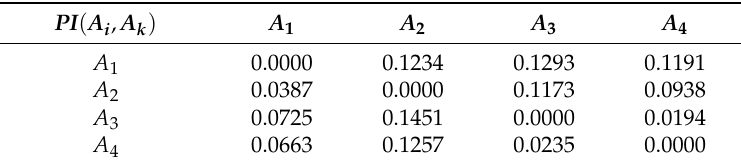
Table 7. The comprehensive preference intensities.